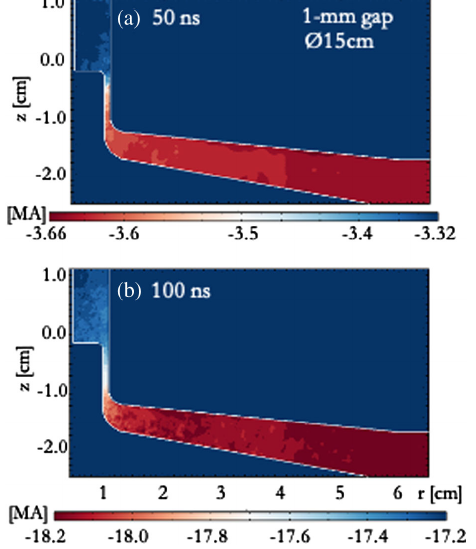
FIG. 10. Current distribution ( rB θ map) in the ∅ 15 cm 1-mm gap simulation [Fig. 8(a)] at (a) 50 ns and (b) 100 ns.